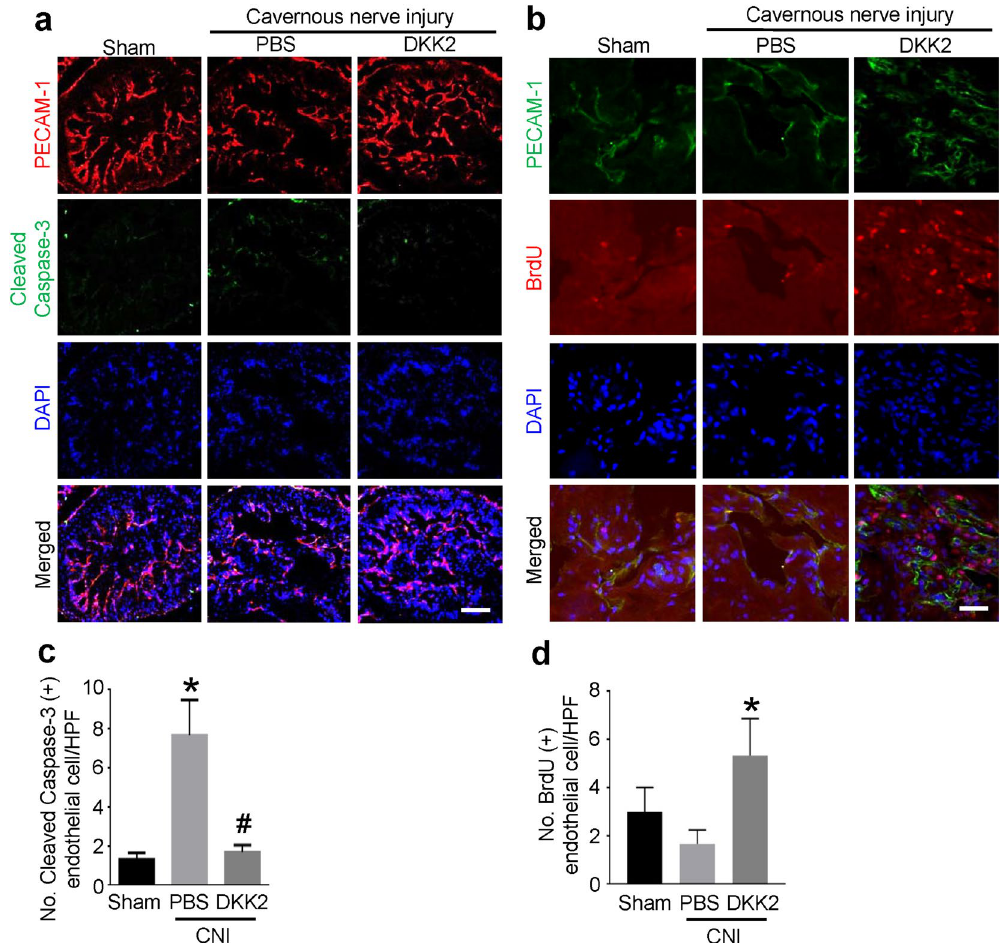
Figure 5. DKK2 decreases cavernous endothelial cell apoptosis and enhances endothelial cell proliferation. ( a , b ) PECAM-1 (red) and cleaved caspase-3 (green) or PECAM-1 (green) and BrdU (red) staining of cavernous tissue from sham operation group or CNI mice 1 week after receiving intracavernous injections of PBS (20 μ l) or DKK2 protein (days -3 and 0; 6 µ g/20 µ l). Nuclei were labeled with DAPI (blue). Scale bar 100 µ m (left row), and 25 µ m (right row). (c) Number of apoptotic cells in endothelial cells per high-power field (screen magnification × 200). Each bar depicts the mean ( ± SE) values from n = 6 animals per group. * P < 0.001 vs. sham operation group, # P < 0.001 vs. PBS group. (d) Number of BrdU-immunopositive endothelial cells per high-power field (screen magnification × 400). Each bar depicts the mean ( ± SE) values from n = 4 animals per group. * P < 0.01 vs. PBS-treated CNI group. CNI = cavernous nerve injury; DKK2 =